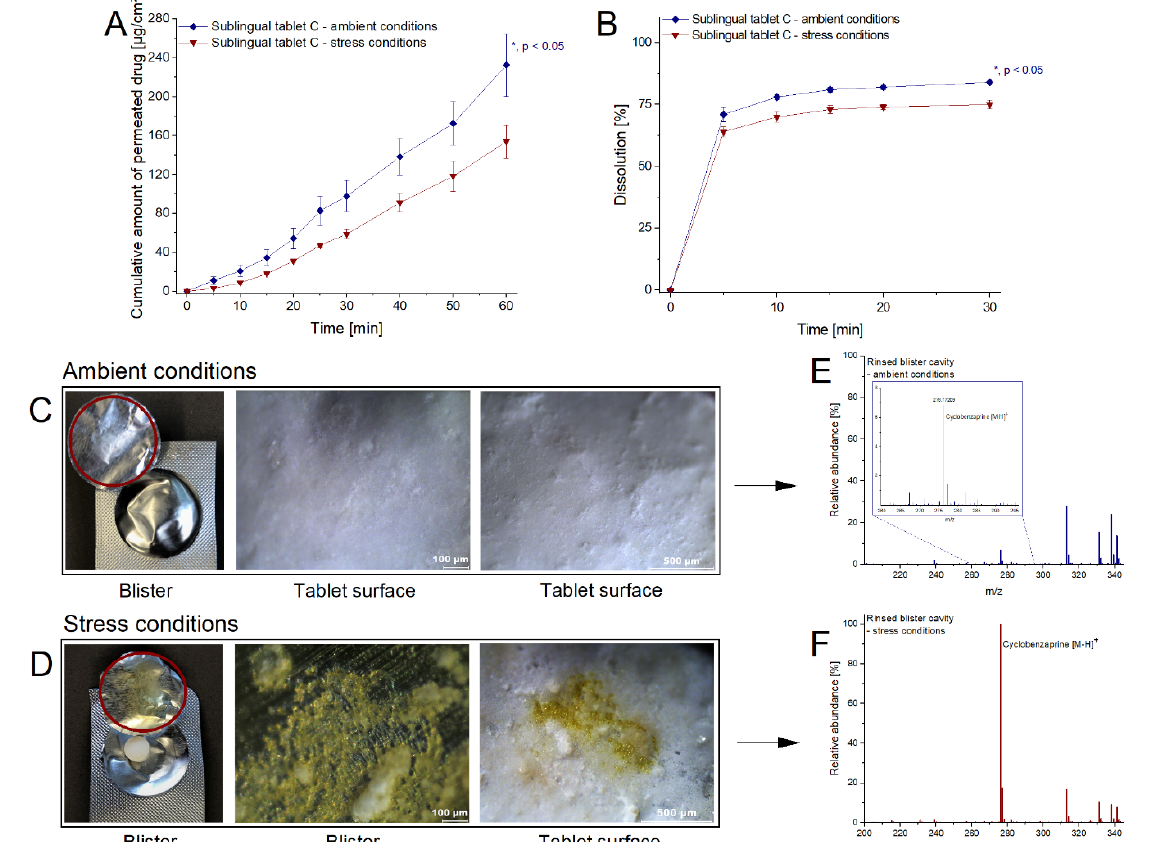
Figure 4. Alteration of cyclobenzaprine sublingual tablets under ambient and stress conditions. A : Cumulative amount of permeated drug per cm 2 of the respective sublingual tablet stored (mean ± SEM; n ≥ 4). B : Dissolution of the respective sublingual tablet stored (mean ± SEM; n = 3). C , D : Visual and microscopic inspection of the primary packaging material and the tablet surface after storage under ambient conditions and stress conditions, respectively. E , F : TOF-MS scan of the rinsed residuals from packaging material after storage under ambient conditions and stress conditions, respectively. m/z: mass-to-charge ratio, SEM: standard error of the mean, *: significant value (p < 0.05; unpaired t-test).